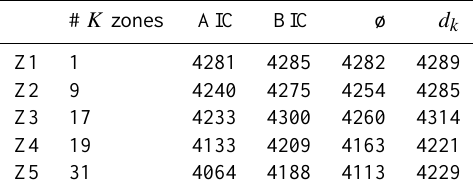
Table 5. Model structure identification based on the following crite- ria implemented in TRANSIN: AIC (Akaike, 1974), BIC (Akaike, 1977), ø (Hannan, 1980) and d k (Kashyap,